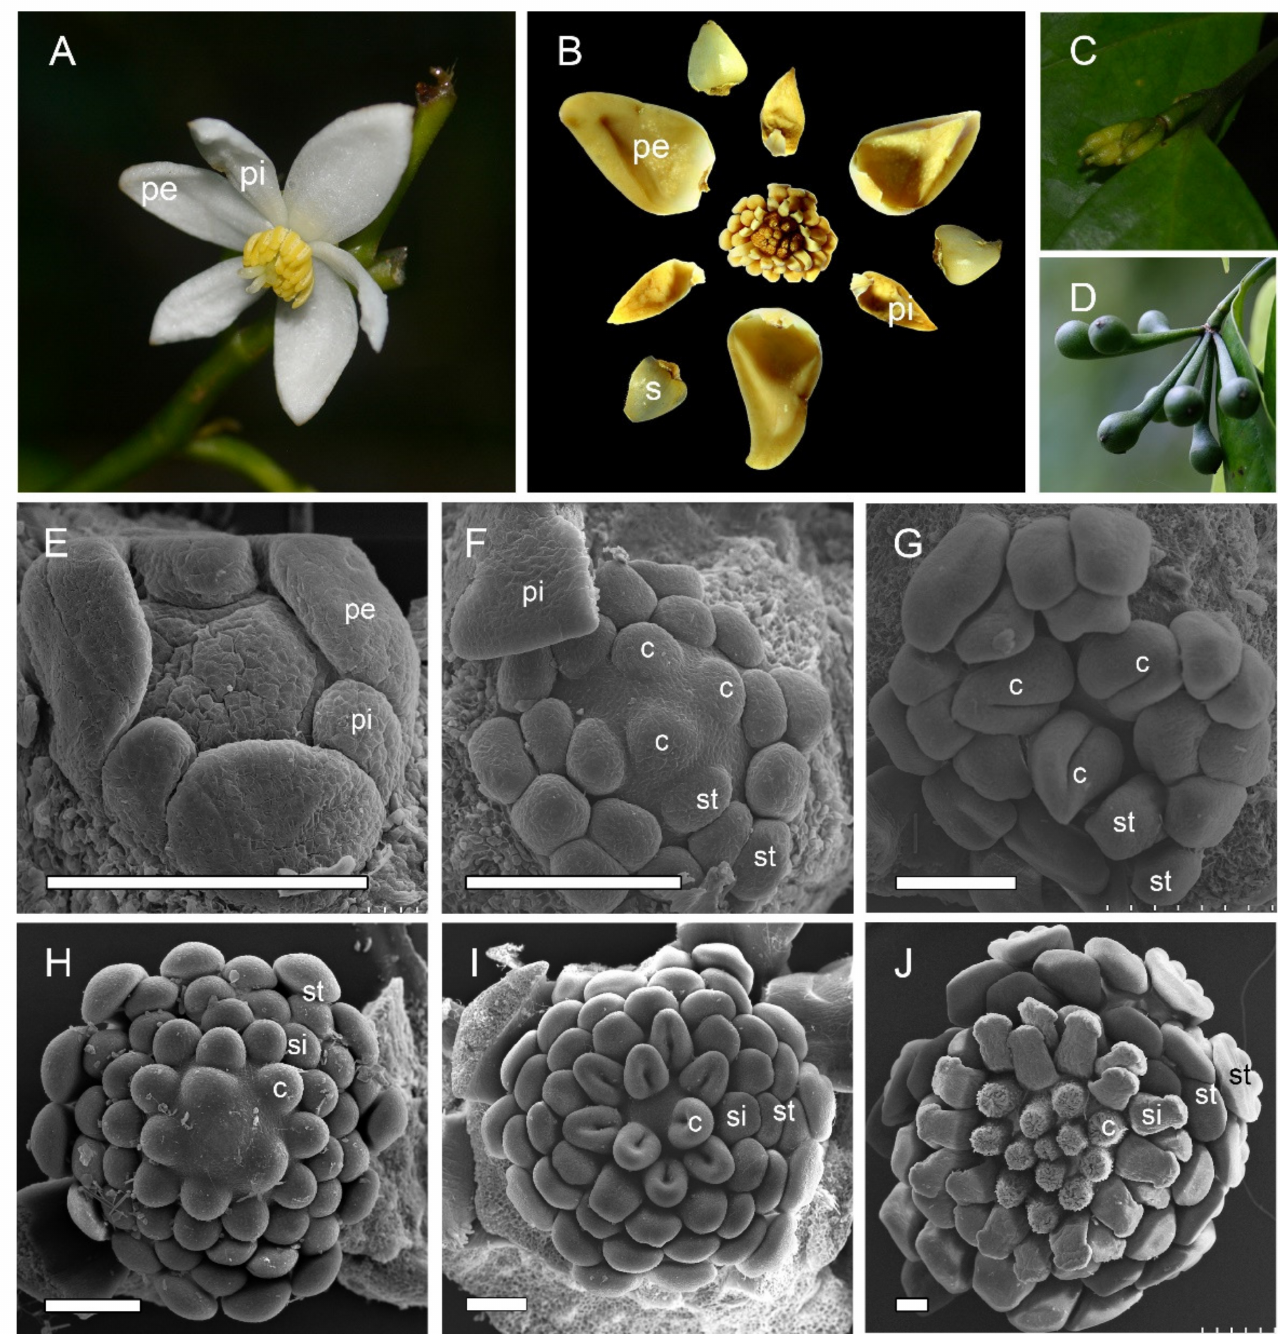
Figure 1. Floral morphology and gynoecium development in two Anaxagorea species. ( A ) Anaxagorea luzonensis flower. ( B ) Anaxagorea javanica flower. ( C ) Young A. luzonensis fruit. ( D ) Mature A. Javanica fruit. ( E – G ) A. luzonensis floral development. ( H – J ) A. Javanica gynoecium development. c, carpel; pe, outer petal; pi, inner petal; s, sepal; si, staminode; st, stamen. Scale bars = 200 µ